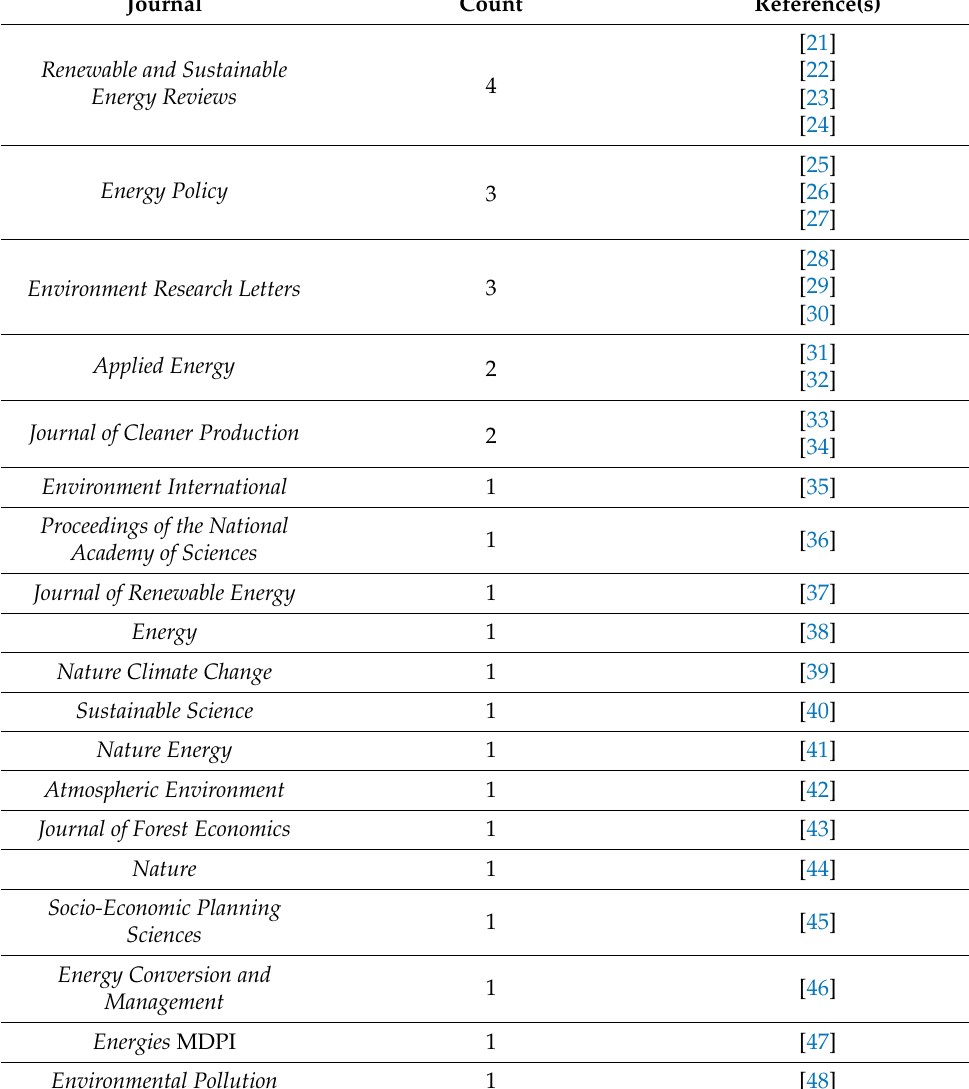
Table 2. Journal of publication (source: own